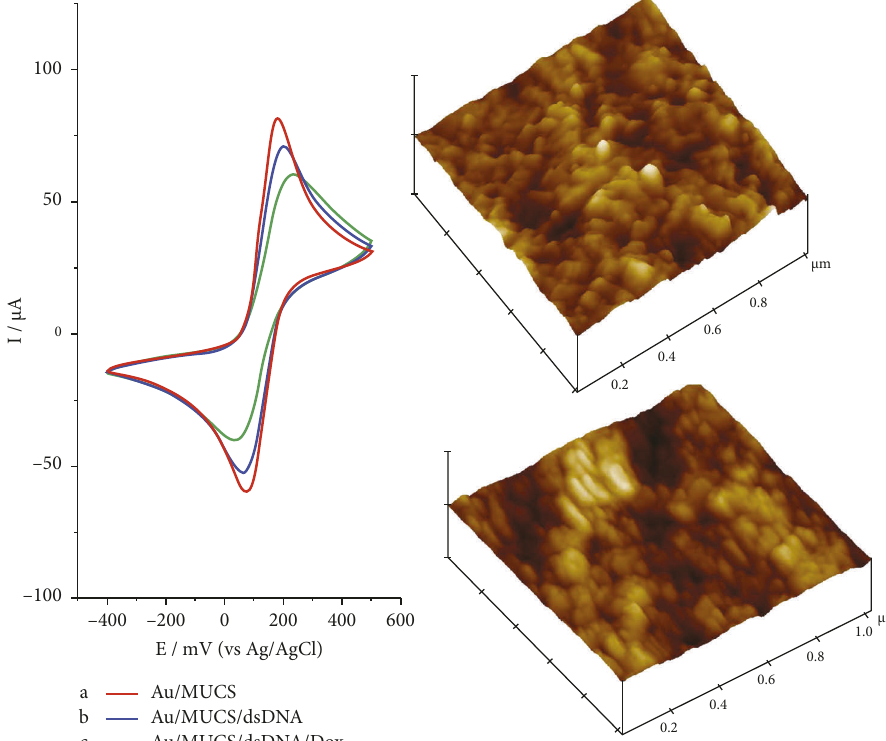
Figure 2: Cyclic voltammograms current of the 20 mM [Fe(CN) − 3/ − 4 redox probe/0.01M PBS (pH 7.4) registered on modified Au/MUCS 6 ] (a), 10 − 6 M Au/MUCS/dsDNA electrode (b), and Au/MUCS/dsDNA/Dox electrode (c). AFM image of 3D morphology of registered on Au/ MERS/dsDNA electrode (b) and modified Au/MCHS/dsDNA/Dox electrode (c), with area of 1 μ m × 1 μ m and Z scale